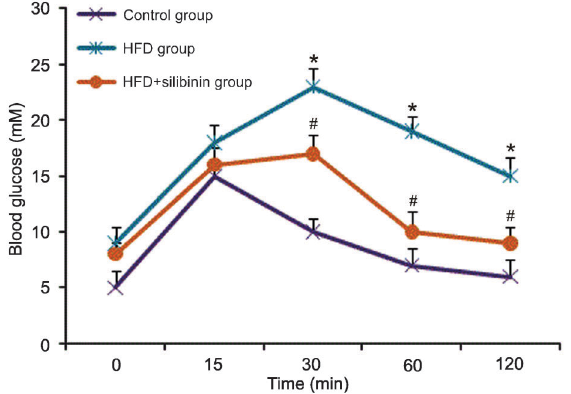
Figure 2. Changes of blood glucose during the intraperitoneal glucose tolerance test (IPGTT) in each group. Fasting glucose and the peak blood glucose value during the IPGTT were markedly higher in the high-fat diet (HFD) group than in the control group and HFD + silibinin group, which showed impairment of sugar tolerance and the presence of insulin resistance. *P , 0.05 for the control group vs HFD group; # P , 0.05 for the HFD + silibinin group vs the HFD group (ANOVA followed by the Bonferroni multiple comparisons test).